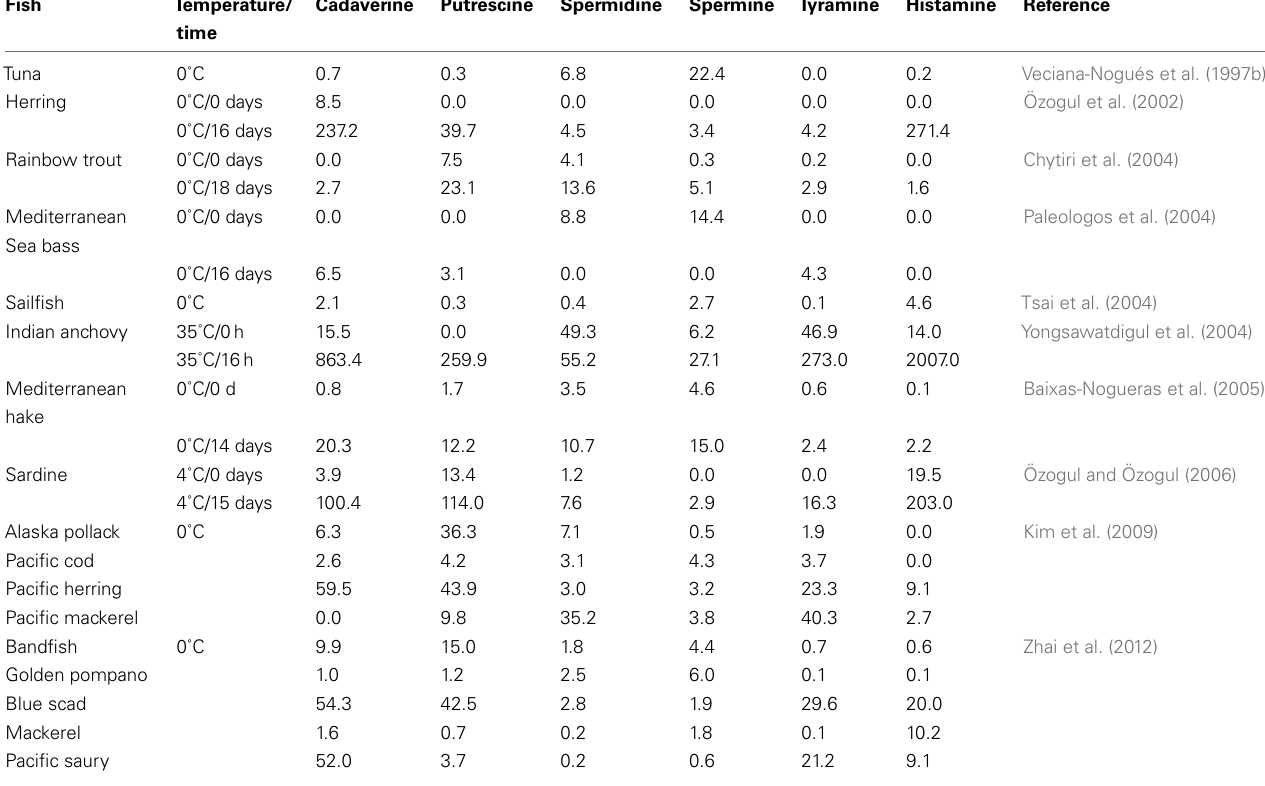
Table 2 | Levels (mean value, mg/kg) of BAs in raw seafood. Fish